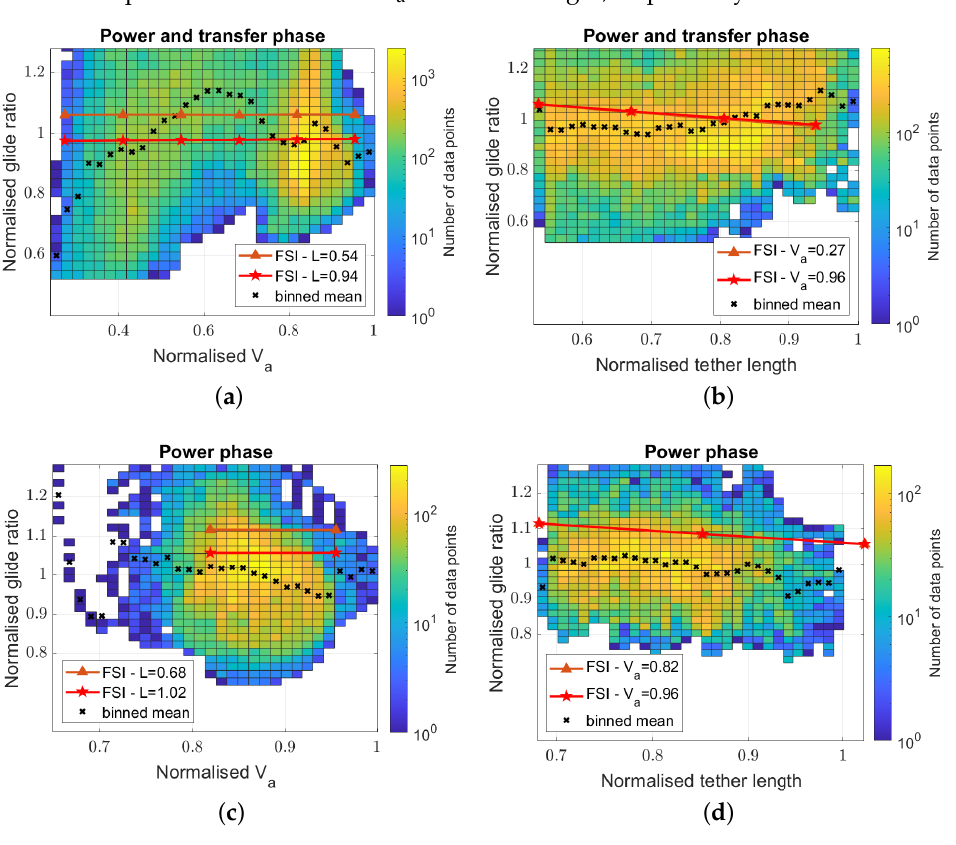
Figure 12. Normalized glide ratio during power and transfer phases [20]. ( a ) Glide ratio against V a . ( b ) Glide ratio against tether length. ( c ) Glide ratio against V a . ( d ) Glide ratio against tether